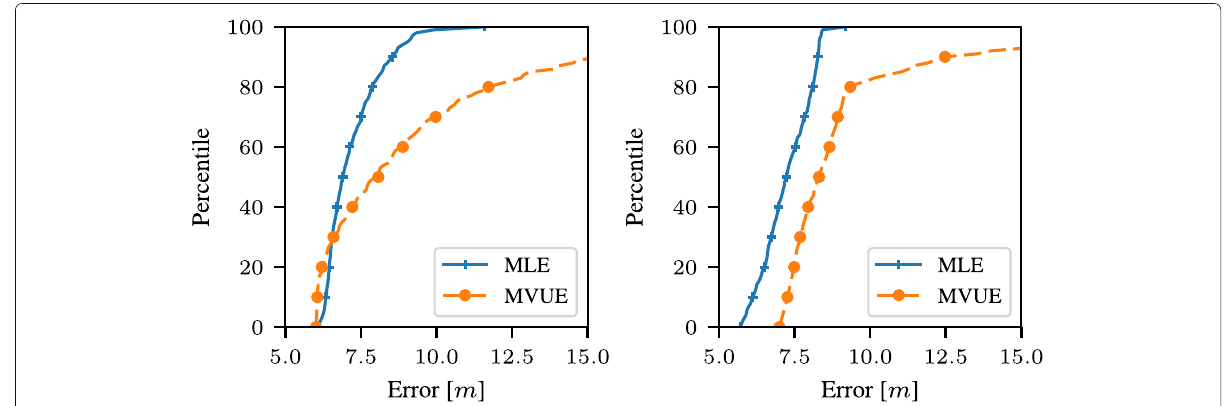
Fig. 9 Position errors (percentiles). On the left for the WSN with node rotation 0°, on the right for a rotation of